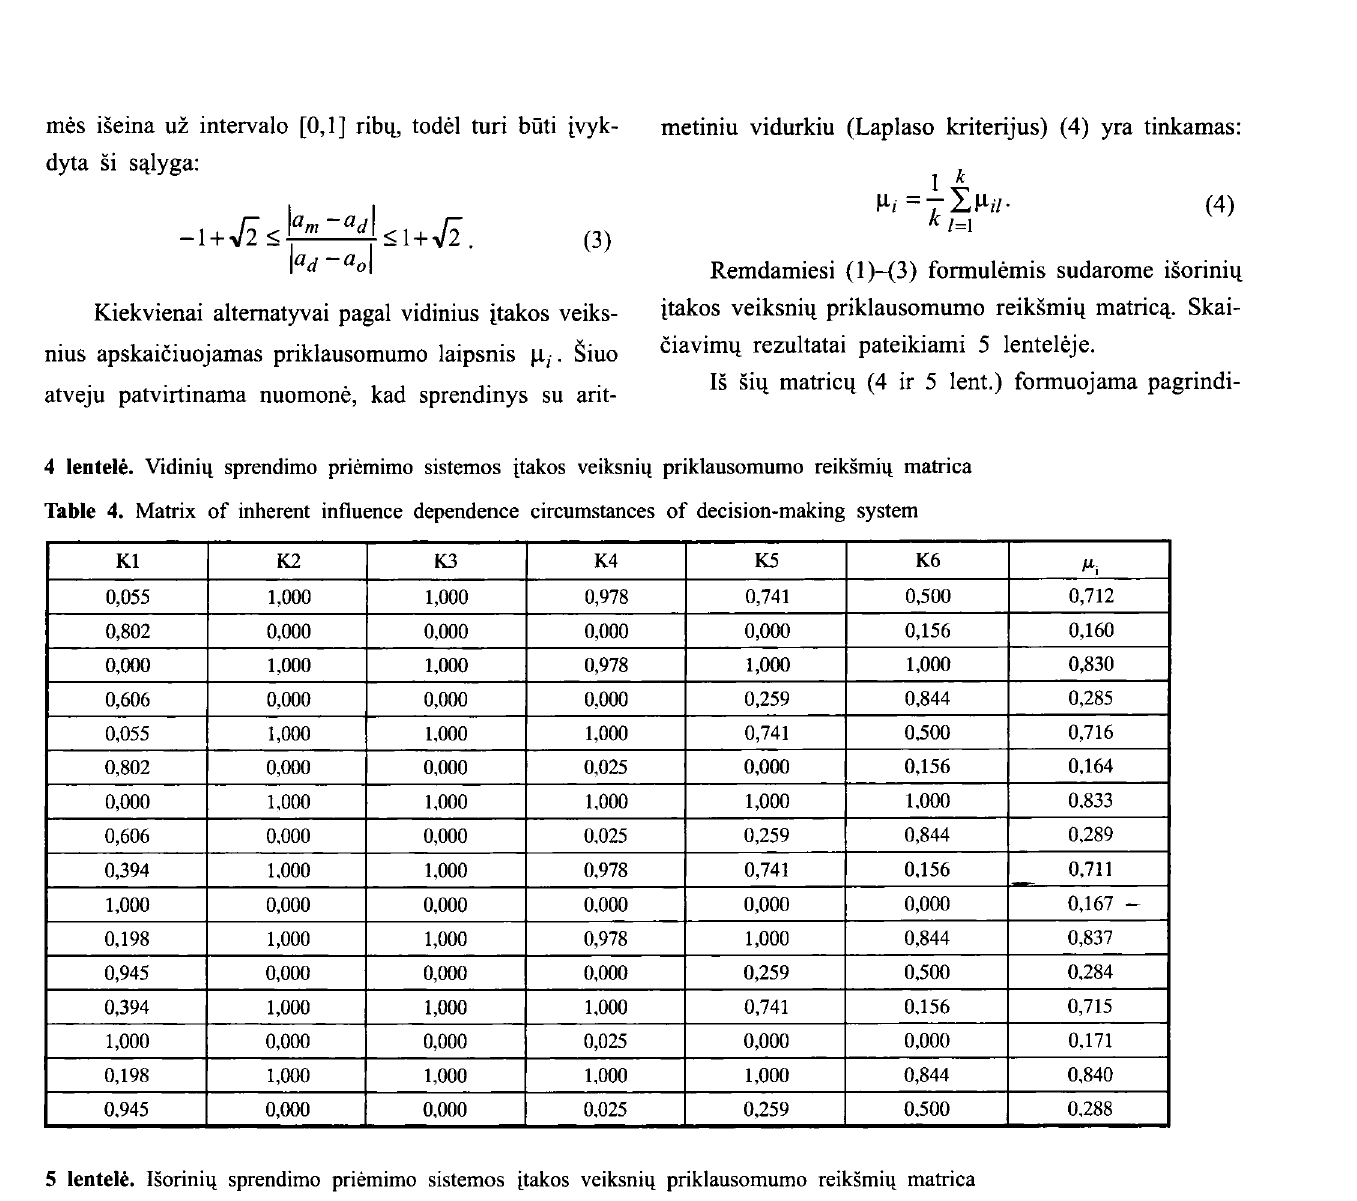
Table 5. Matrix of outward influence dependence circumstances of decision-making system Y1 Y2